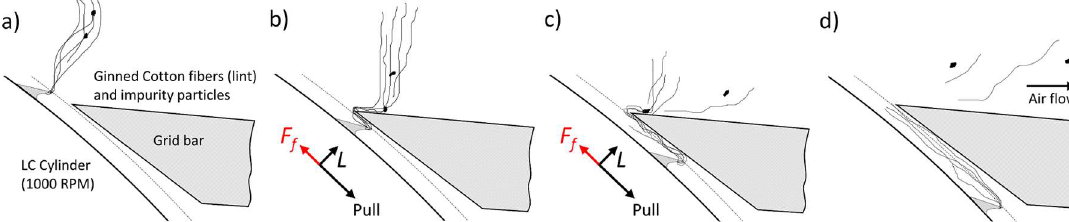
Figure 2. Mechanism of the fiber–grid bar interaction: ( a ) fiber tuft is elevated from the cylinder surface due to centrifugal forces; ( b ) the middle section of the fiber tuft impacts against the edge of the grid bar; ( c ) the tuft rapidly slides over the grid bar; ( d ) the fiber tuft travels past the grid bar while impurity particles rebound from it.